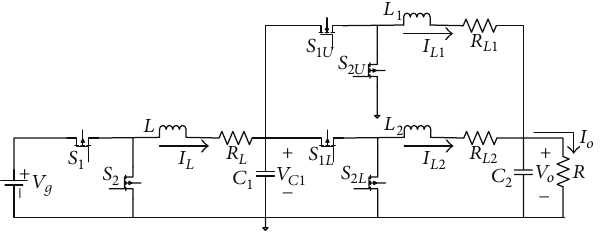
Figure 4: Synchronized Buck converter with postfilter in inter- leaved operation (BuckPS).